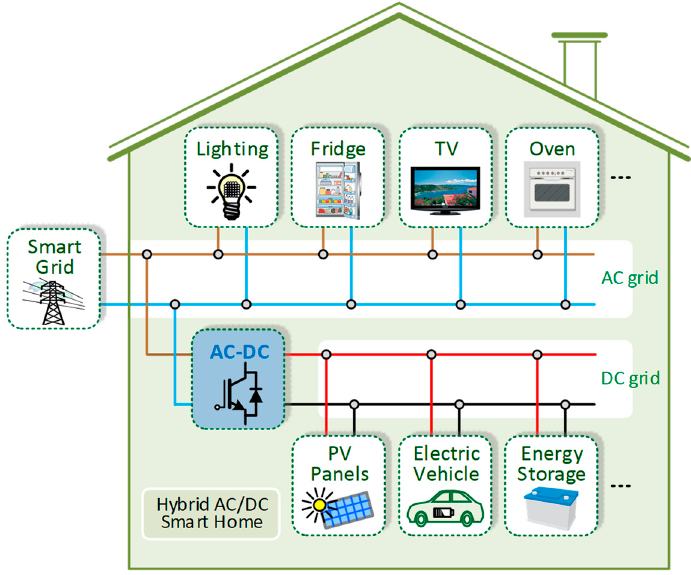
Figure 1. Contextualization of a front-end AC/DC converter in a hybrid AC/DC smart